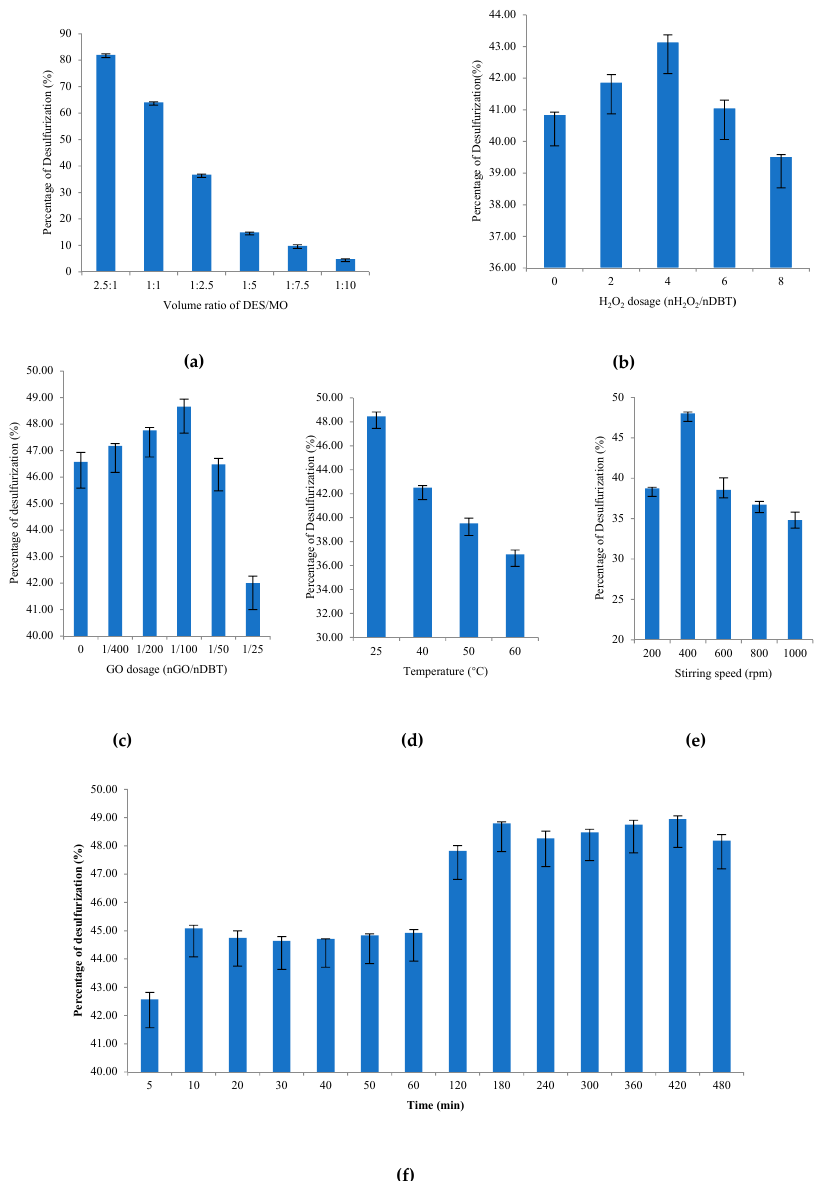
Figure 9. The optimized parameters of extractive catalytic oxidative desulfurization (ECODS) method including ( a ) DES/MO ratio ( b ) H 2 O 2 /s molar ratio ( c ) GO/S mass ratio ( d ) reaction temperature ( e ) stirring speed and ( f ) reaction time.